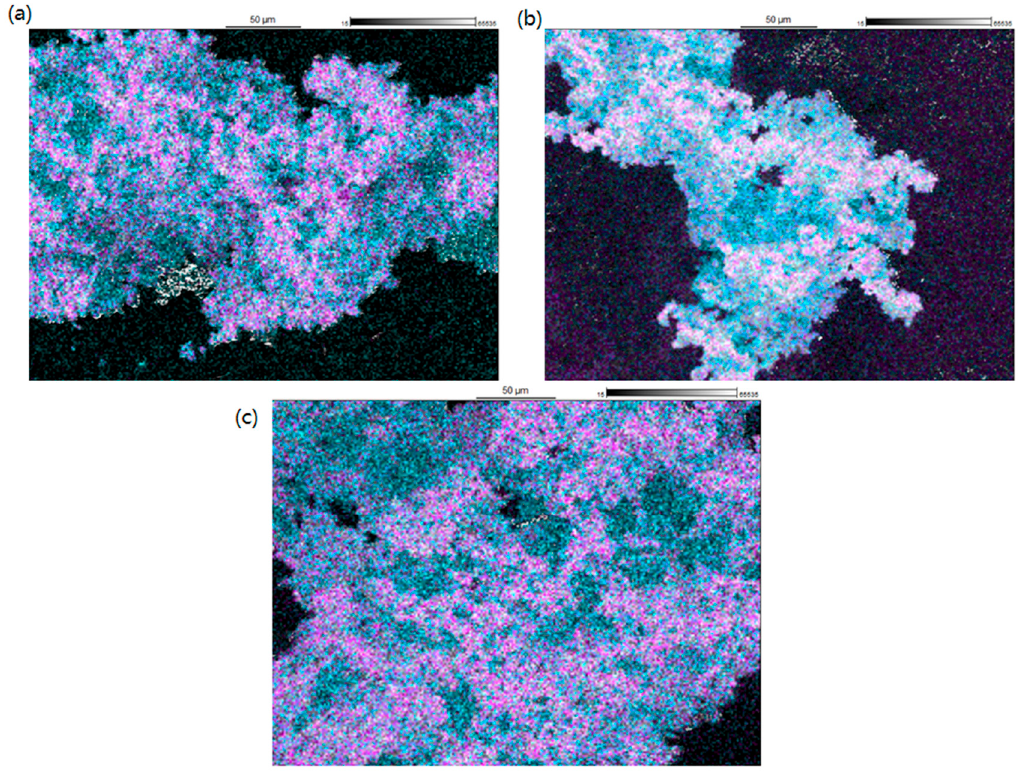
Figure 3. Distribution of Na (•) and S (•) on the spray-dried particle surfaces measured by EDS: ( a ) SVS-LYS from 5% SLS; ( b ) SVS-LYS from 0.5% SLS; and ( c ) SVS from 5% SLS. Table 3. Melting temperature (T m ), glass transition (T g ), and recrystallization temperature (T rc ) of the pure starting materials compared to the prepared